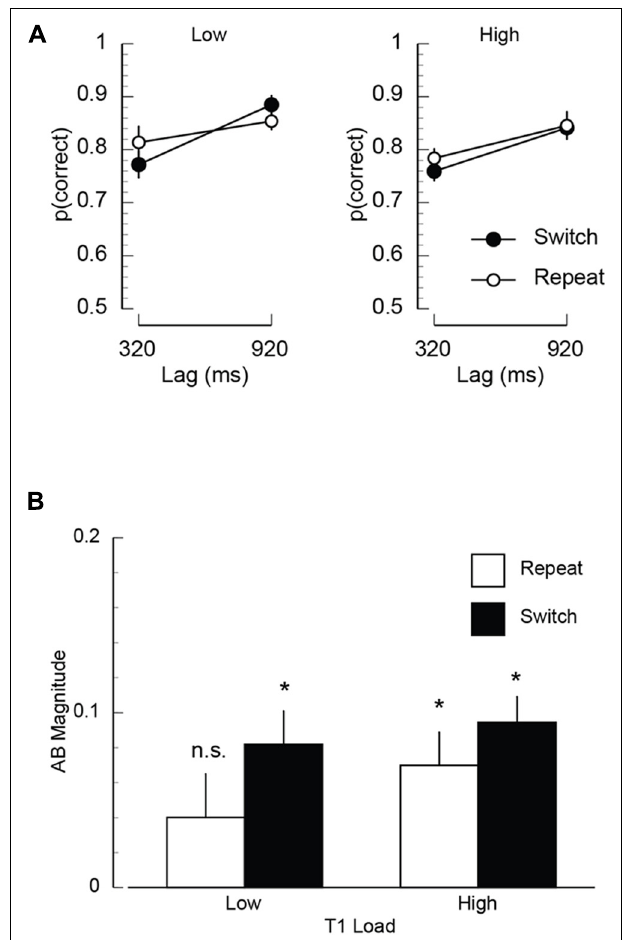
FIGURE 2 | Mean task 2 behavioral performance in Experiment 1 . (A) Mean proportion of correct responses on the second target (T2) task, plotted as a function ofT1 load (high/low),T1–T2 lag (320/920 ms), and inter-trialT1-load dependency (repeat/switch). (B) Mean AB magnitude plotted as a function ofT1 load and inter-trialT1-load dependency. Asterisks indicate that AB magnitude was significantly different than zero at p < 0.05, FDR-corrected for multiple